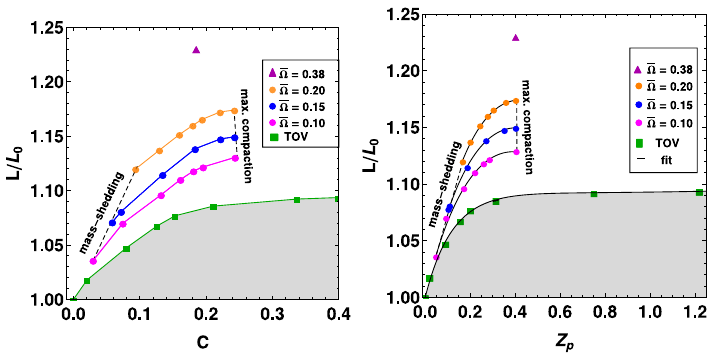
Fig. 40 Pulsar spin-down luminosity L normalized by L 0 = 1 . 02 μ 2 Ω 4 , the flat-spacetime result. Left panel: L / L 0 versus stellar compactness C = M / R e , where R e is the equatorial radius. Right panel: L / L 0 vs polar redshift Z p . The parameter space for rotating stars is contained between the left dashed line (the mass-shedding limit) and the right dashed line (maximum compactness). The top point (triangle) represents the value for the supramassive neutron star limit for n = 1. For these rapidly rotating stars, the lower shaded zone is the area of the parameter space that cannot be reached, unless flat spacetime is assumed. In the constant angular velocity sequences ¯ Ω = Ω · K n / 2 is a dimensionless angular velocity, with K standing for the polytropic constant. (Image reproduced with permission from Ruiz et al. 2014, copyright by